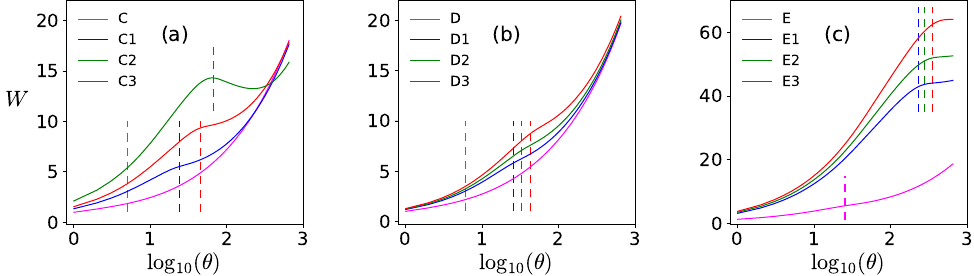
Figure 5. Roughness of films grown in simulations with ES barriers. The values of d c of all sets are indicated by the dashed vertical lines. All lengths are in units of the lattice